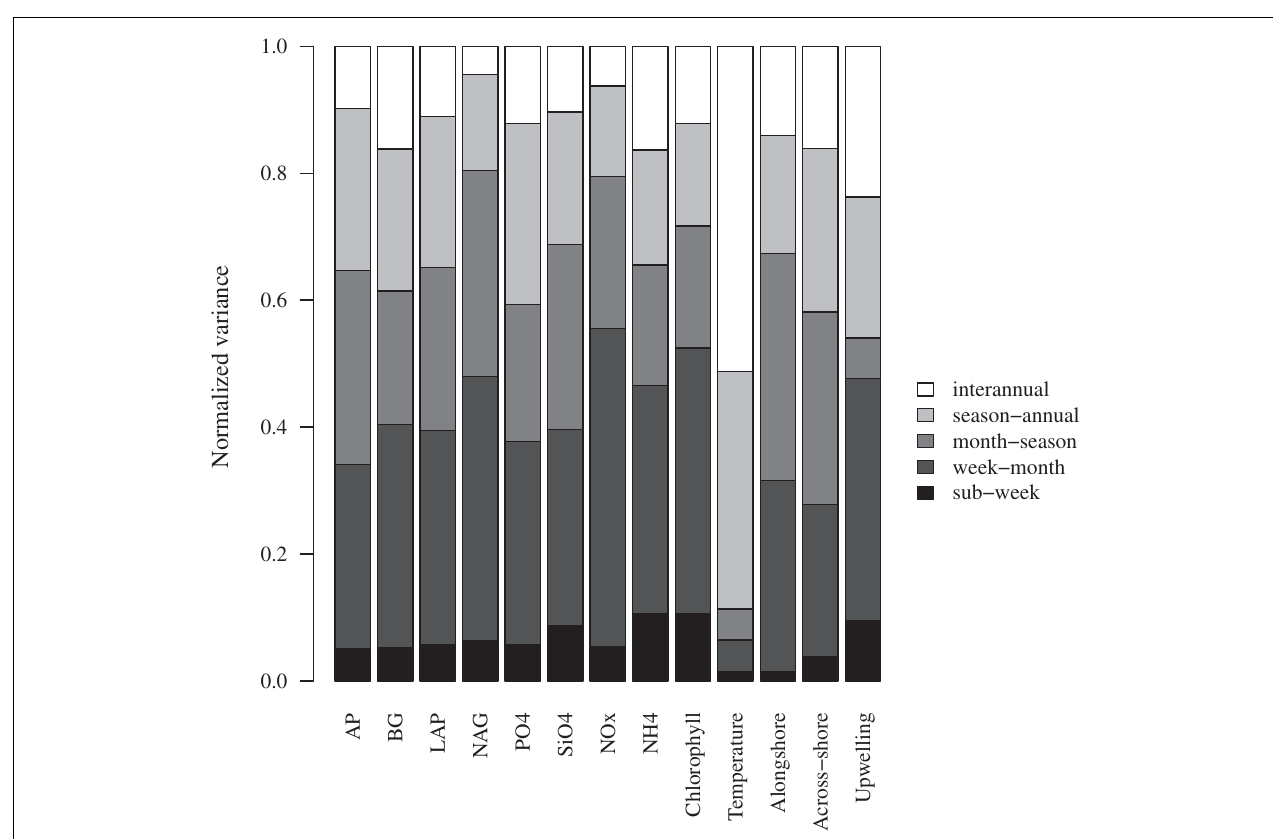
FIGURE 3 |Variance at different timescales for bulk seawater extracellular enzyme activities, seawater nutrient concentrations, chlorophyll a concentrations, and sea surface temperature. The total variance for each variable was normalized to 1.0 to facilitate comparison. AP, alkaline phosphatase; BG, β -glucosidase; NAG, N -acetyl-glucosaminidase; LAP, leucine aminopeptidase. Alongshore and across-shore refer to surface current directions.